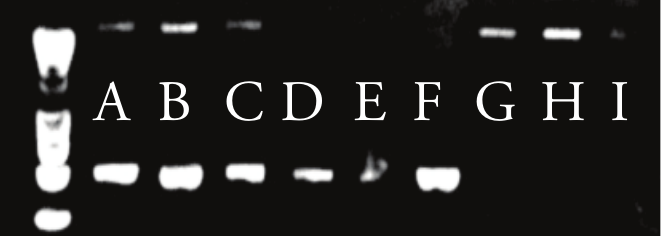
Supplementary Figure S1. Sample gel obtained on 9 total DNA extractions (A–C: bacteria and page, D–F: phage only, following extraction as explained in text, G-I: bacteria following exposure to inactivated phage, whose DNA was extracted after removal of inactivated phages). The primers TPV1f and TPV1r yield a 1200 bp amplicon in the bacteria, and a 500 bp amplicon in phages. Our seperation method for bacteria and phage was complete, since only DNA of the intended organism was found in any given